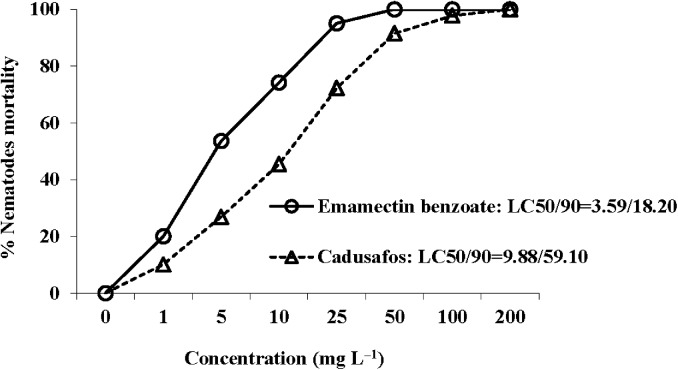
Nematode mortality (%) and lethal concentrations (LC50 and LC90) (mg L-1) of emamectin benzoate and cadusafos against Meloidogyne incognita (Kofoid and White, 1919) Chitwood, 1949 juveniles (J2, after 48h).